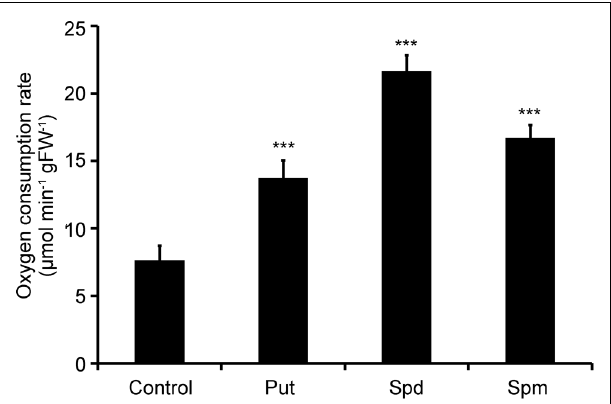
FIGURE 1 | Effect of exogenous polyamines on oxygen consumption rate in Arabidopsis . Arabidopsis Col-0 seedlings were treated with 1 mM Put, Spd, or Spm for a period of 10 min, and oxygen consumption rate was estimated by a Clark-type electrode. Data are the means of three independent experiments ± SD. Asterisks indicate statistical significant differences (*** P <